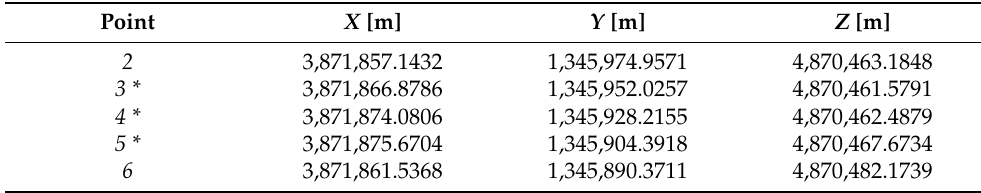
Table 2. Coordinates of reference points ( 2 and 6 ) and approximate coordinates (*) of points to be determined ( 3 , 4 , 5 )—geocentric system ETRF’89.